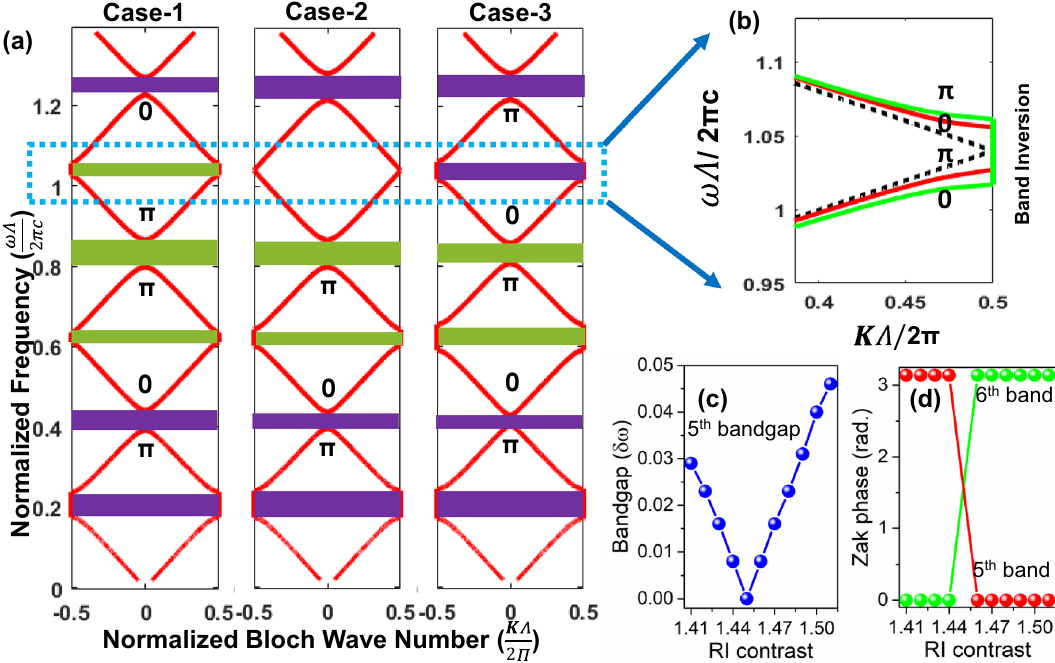
Figure 2. ( a ) Folded bandstructure of a periodic 1D PhC with inversion symmetric unit cell for three topologically distinct cases; ( b ) Topological phase transition around the 5 th order bandgap; ( c ) Bandgap evolution with small changes in the PhC RI contrast, and ( d ) corresponding transitions in the topological